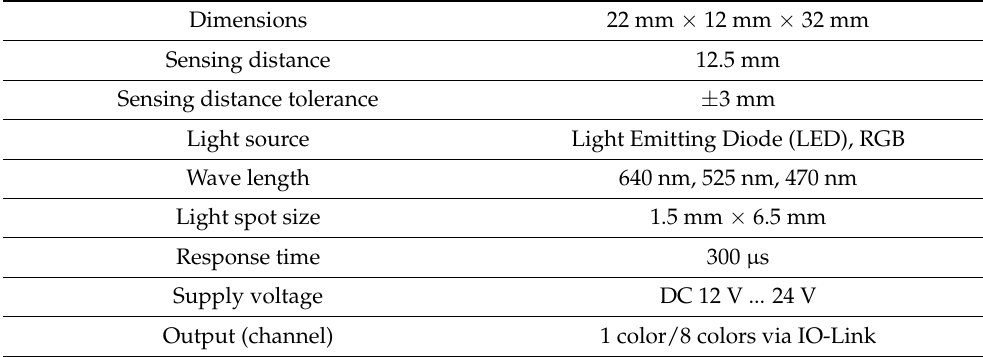
Table 3. CSM-WP117A2P color sensor